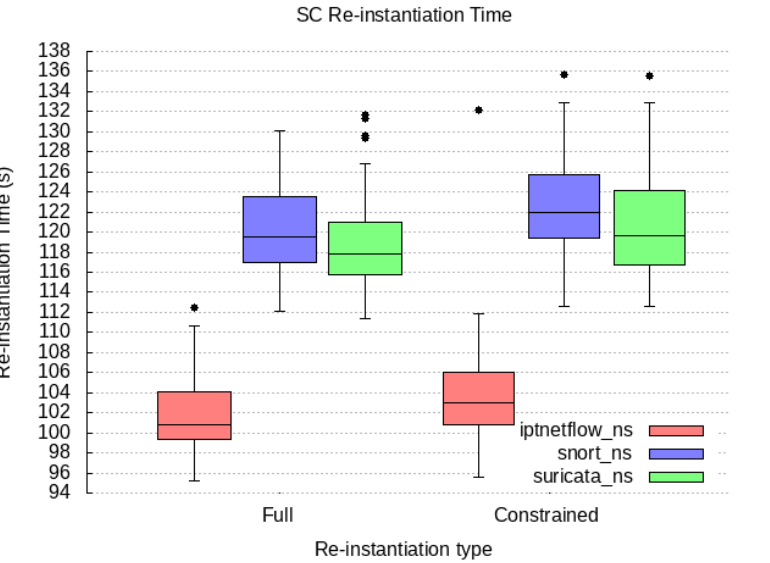
Figure 12. Distribution of reinstantiation times for the three devised SCs, comparing full ( left ) and constrained ( right ) deployments.